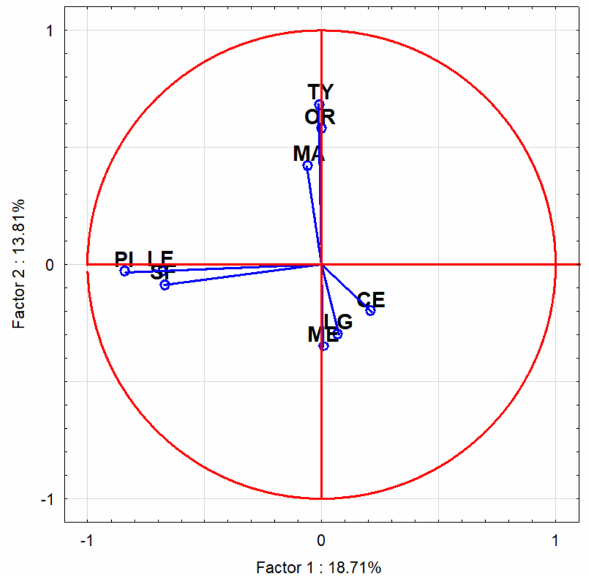
Figure 3. Principal component analysis of 9 analyzed essential oils based on their chemical composition. PI—pine needle EO; LE—lemon EO; SF—silver fir EO; TY—thyme EO; LG—lemongrass